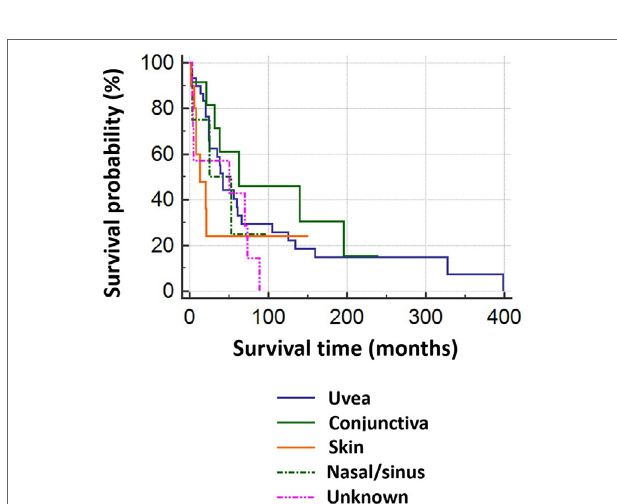
FigUre 3 | Kaplan–Meier survival analysis for 69 patients with orbital melanoma secondary to primary disease at another site, classified by origin of the primary tumor.